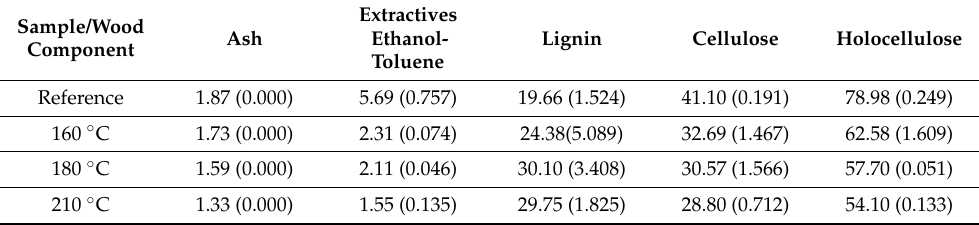
Table 4. Chemical composition (in mass % of oven dried samples).